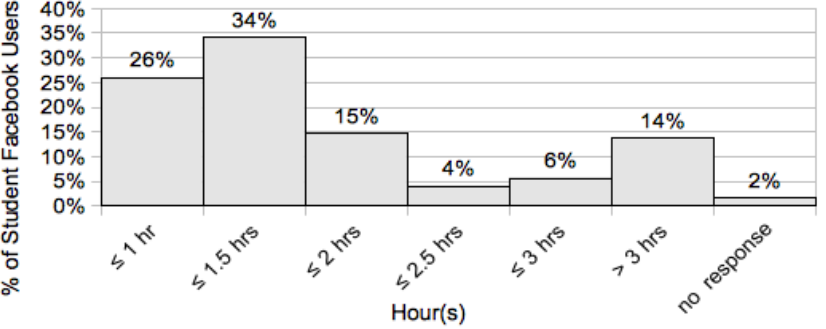
Figure 6 . Average time spent on Facebook per